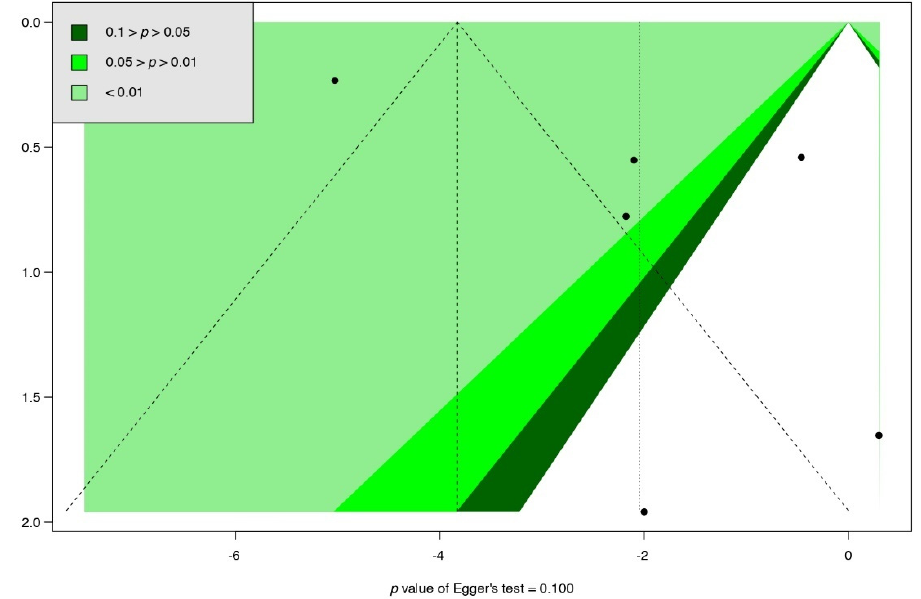
Figure A45. Comparison-adjusted funnel plot in outcome for hospital stay.